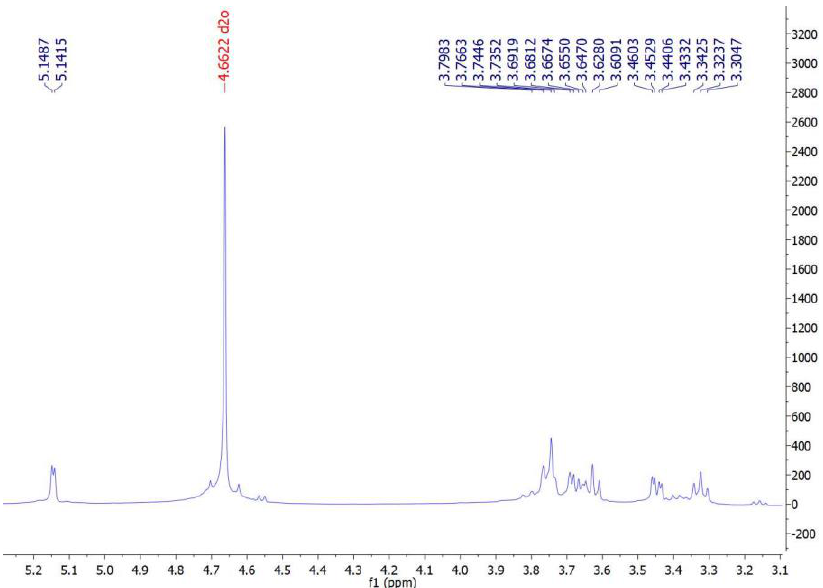
Figure 3. 1 H NMR spectrum of extracted ALG in D 2 O and its characteristic signals.